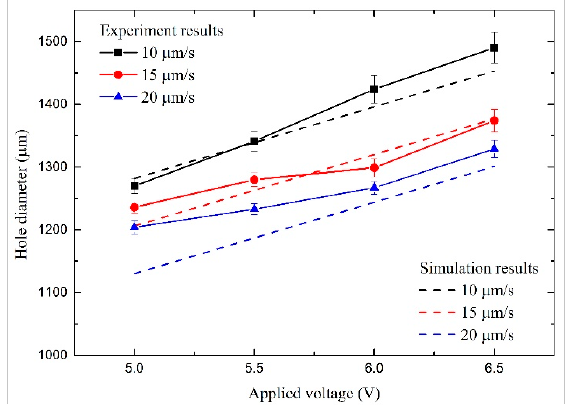
Figure 11. Variation in hole diameter with applied voltage and feed rate.